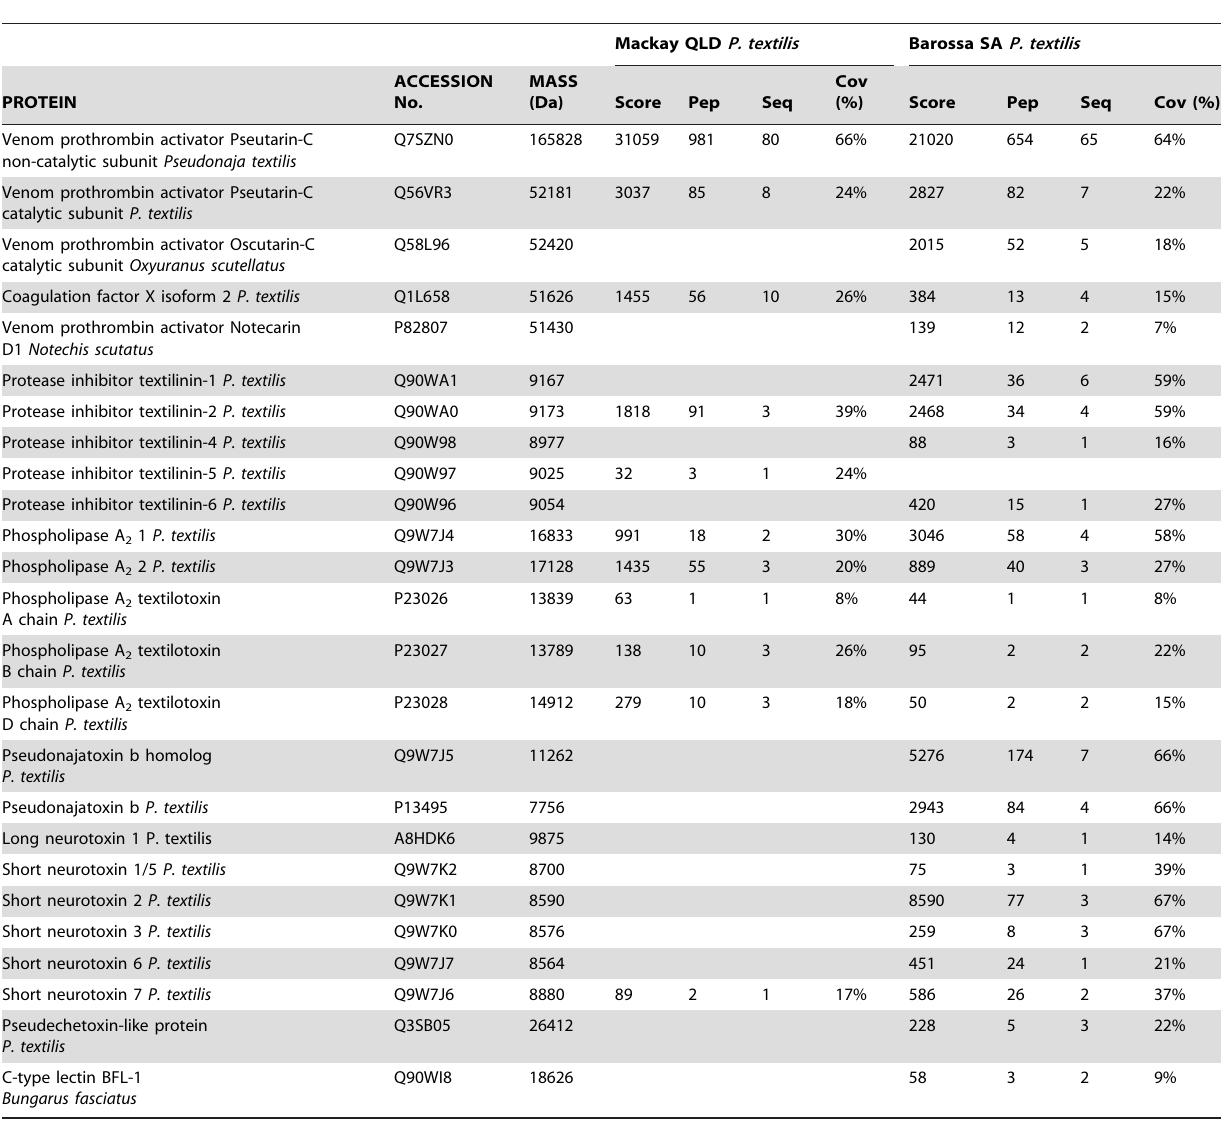
Table 1. LC-MS/MS profile of Pseudonaja textilis population venom proteomes.